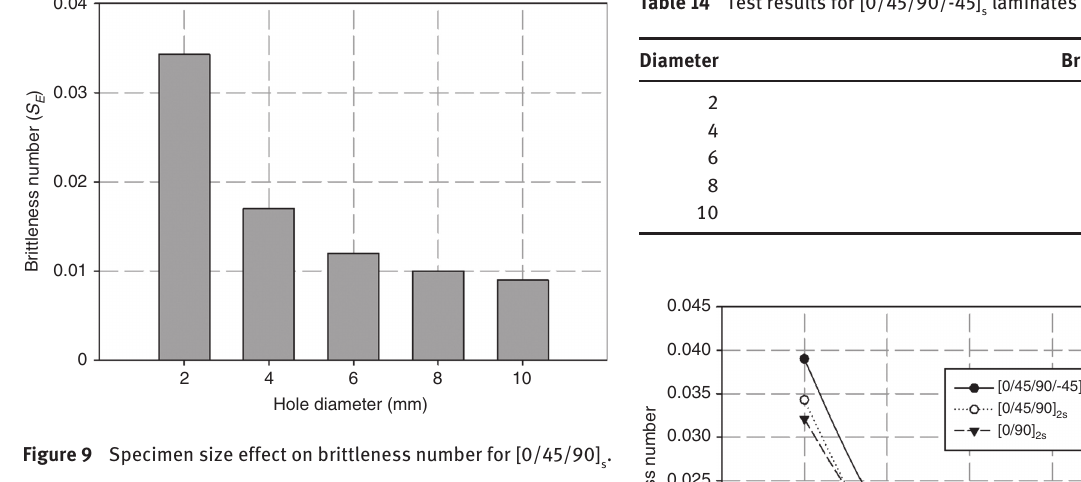
Figure 9 Specimen size effect on brittleness number for [0/45/90]